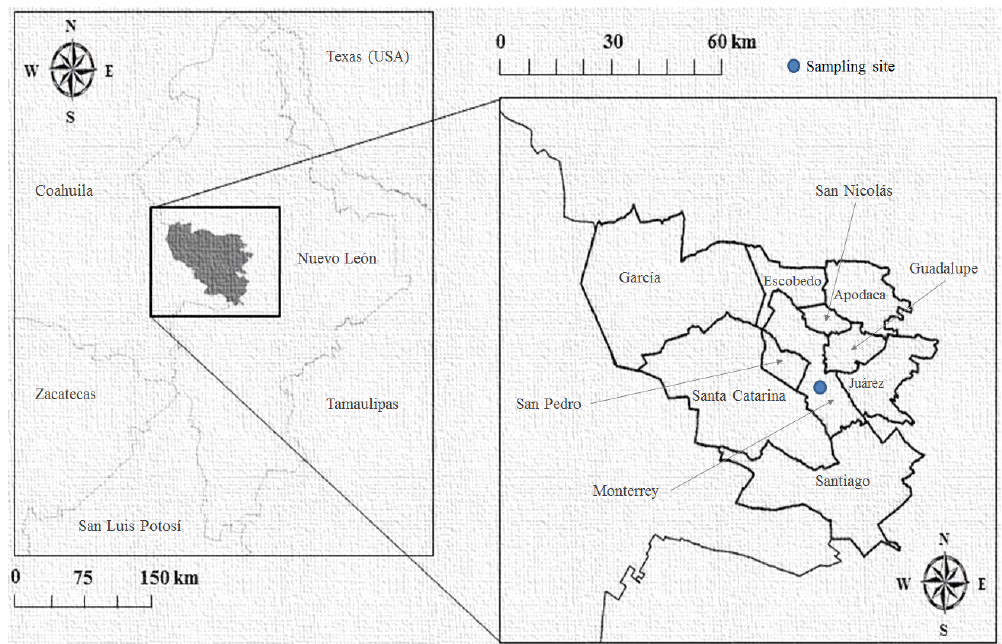
Figure 1. Location and municipalities of the Monterrey metropolitan area (MMA); the sampling site was set up in the